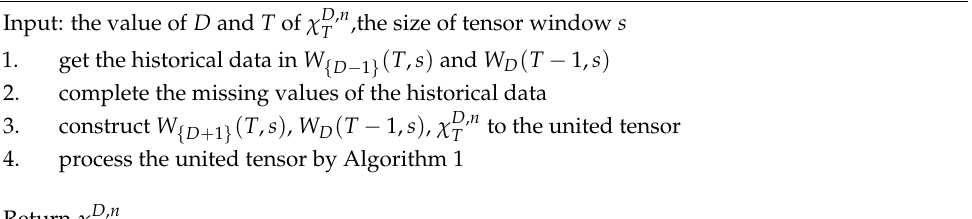
Algorithm 3 Traffic Flow Prediction Algorithm Based on Data Completion Strategy